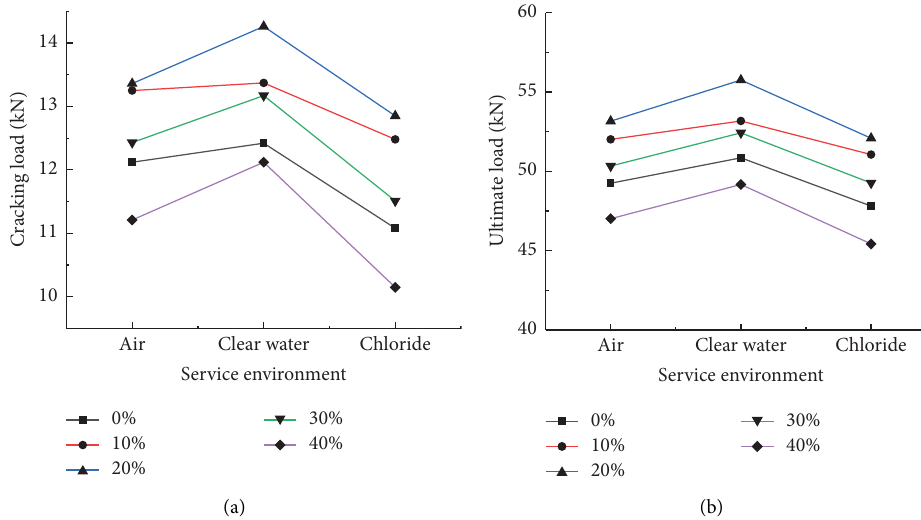
Figure 6: Infuence of service environment on cracking load and ultimate load of test beam. (a) Cracking load and (b) Ultimate load.